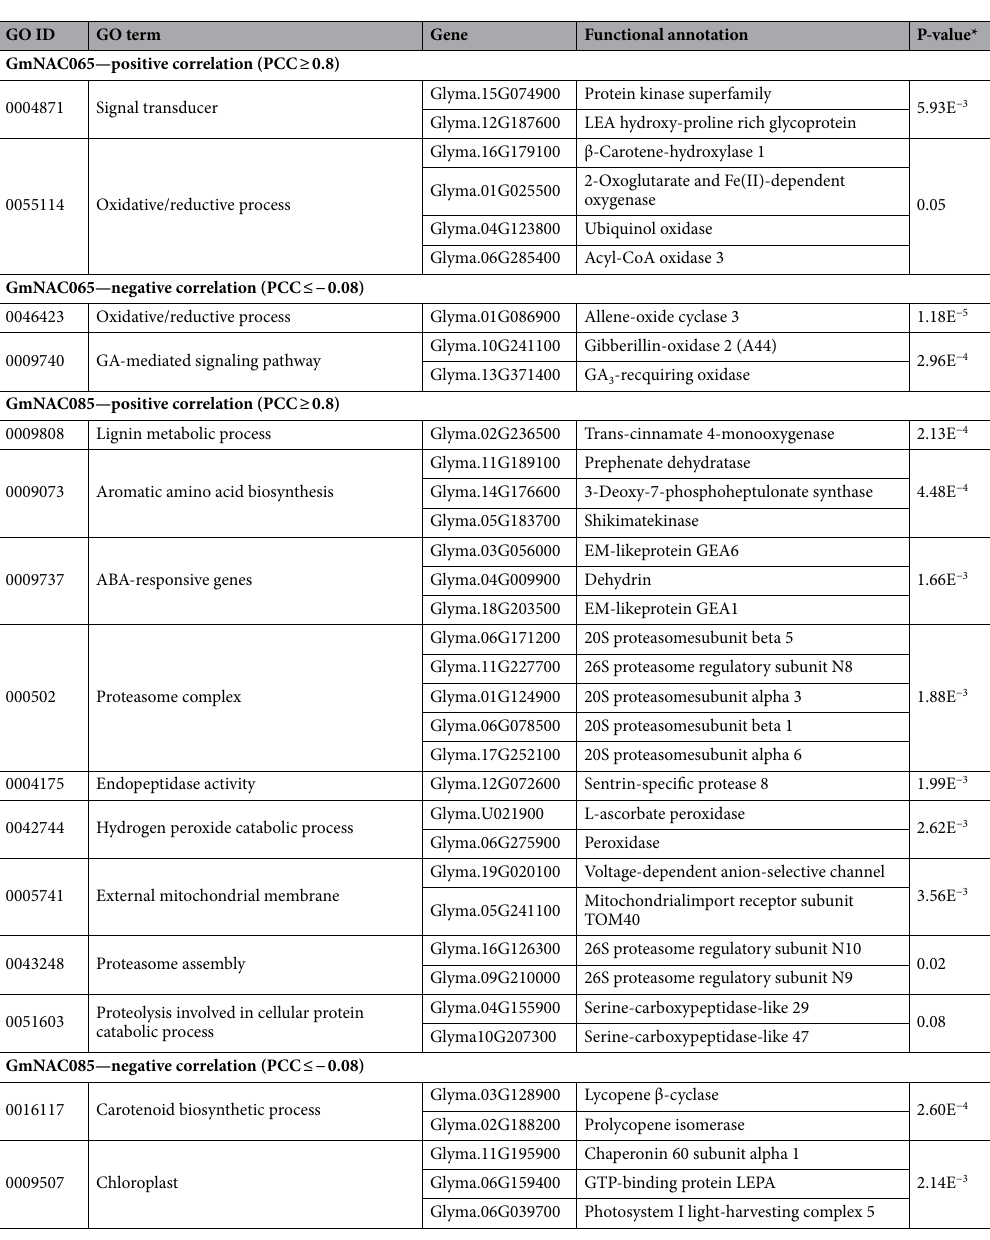
Table 2. GmNAC065 and GmNAC085 co-expressed genes in soybean under biotic and abiotic stresses. *P-value of statistical analysis of FDR (false discovery rate) for